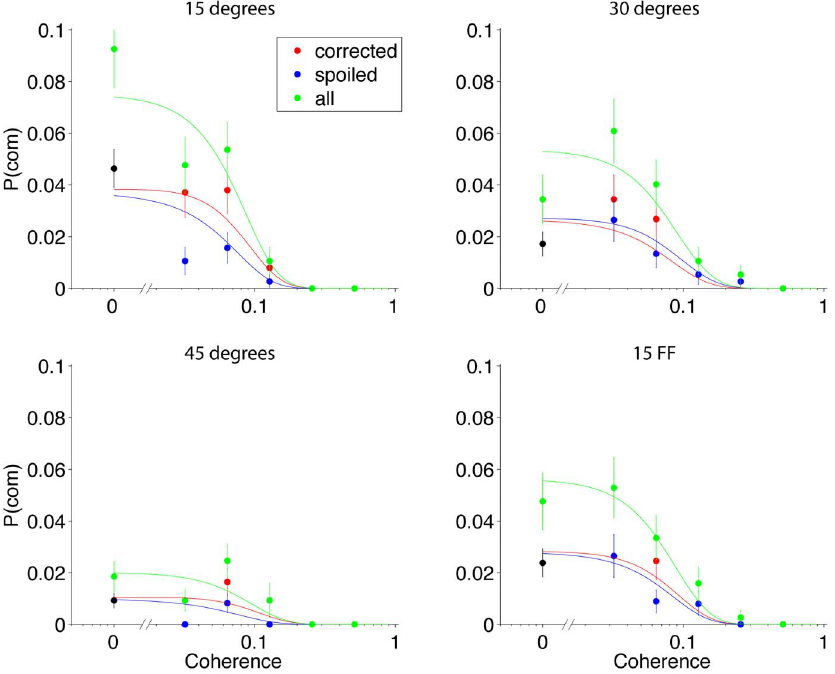
Figure 7. Pattern of changes of mind for Subject 2. Probability of a change of mind as a function of (unsigned) motion coherence for the four conditions. Green circles are all change of mind trials, red are initial errors that were corrected and blue are trials that spoiled an initially correct choice. Solid curves are model fits to the data for the change of mind model. Error bars are s.e.